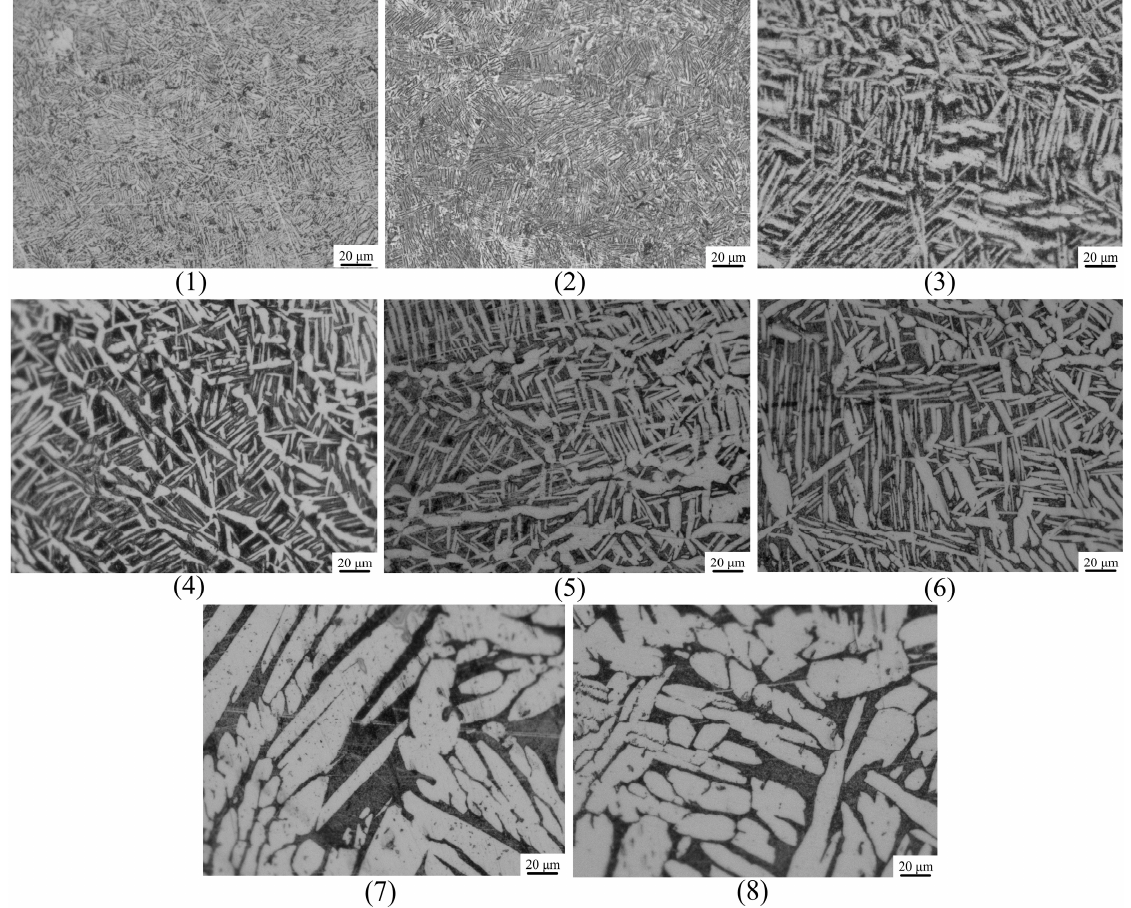
Figure 15. Microstructure after different solution-aging schemes. ( 1 )–( 8 ) indicates the scheme number. The cooling method was water-cooled in order to retain the high-temperature super- saturated solid solution, which was generated by the dissolution of the unstable α